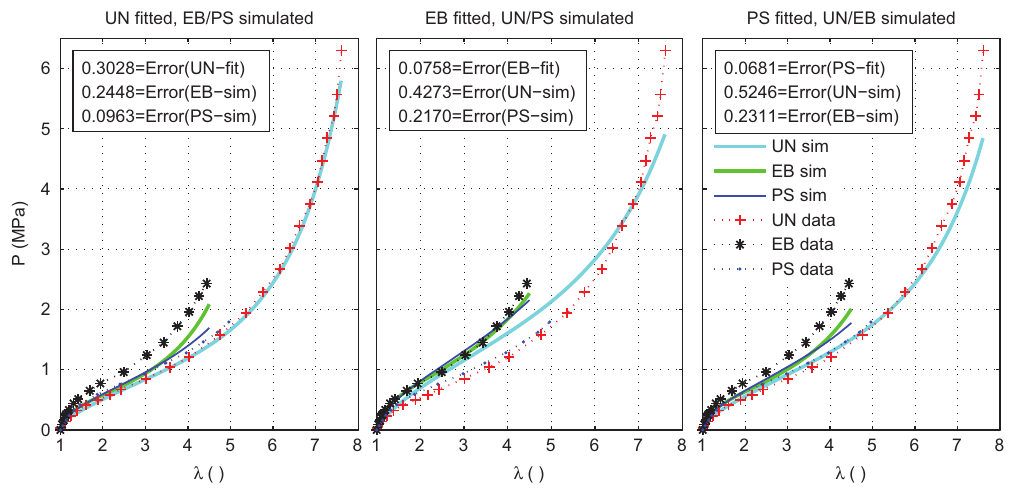
Figure 6 Performance of the Alexander model on the Treloar data. Despite the presence of a higher number of parameters (four in total), the fitting quality and the simulation are not improved than the three- parameter Hart-Smith